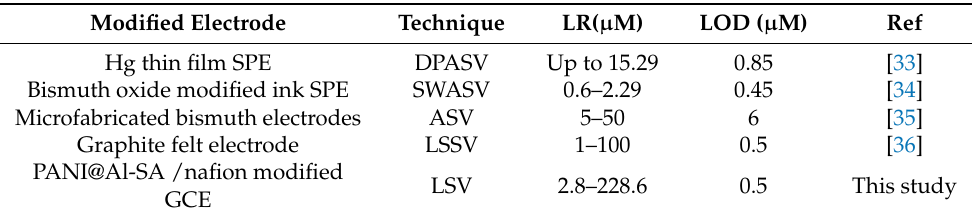
Table 1. Comparison of sensor performances for detection of Zn 2+ with different modified electrodes by electrochemical methods.